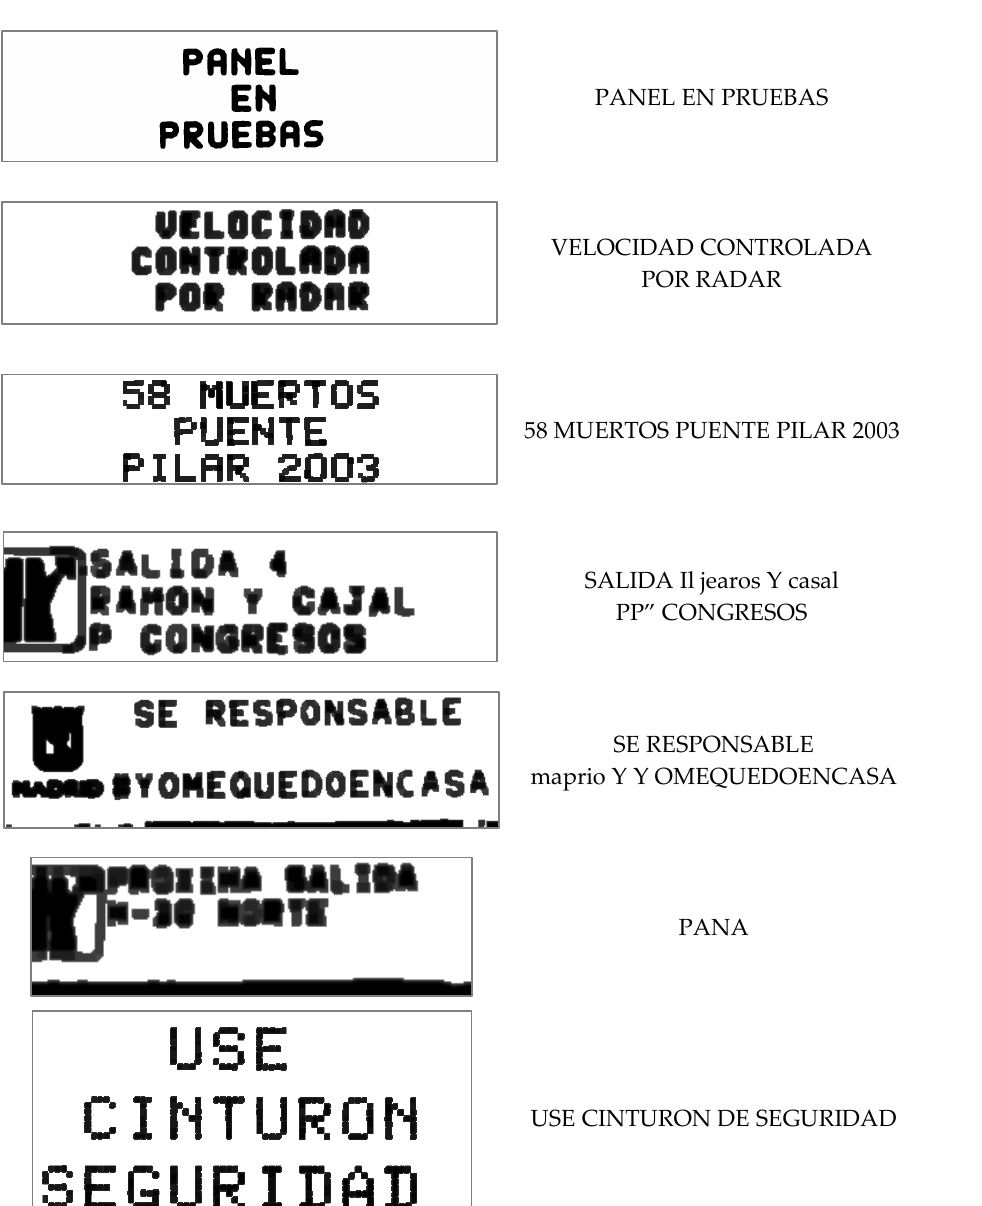
Figure 7. Some examples of OCR (part 1).